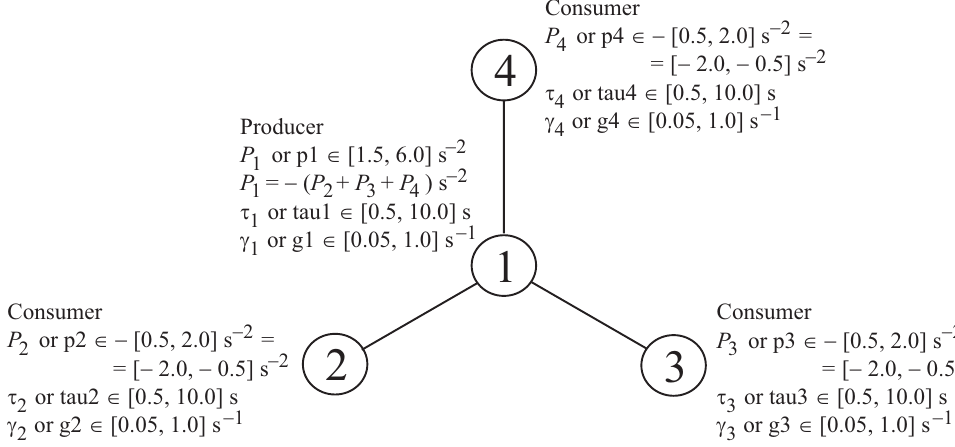
Figure 1. An illustration of the four-node star DSGC system structure in a simulation